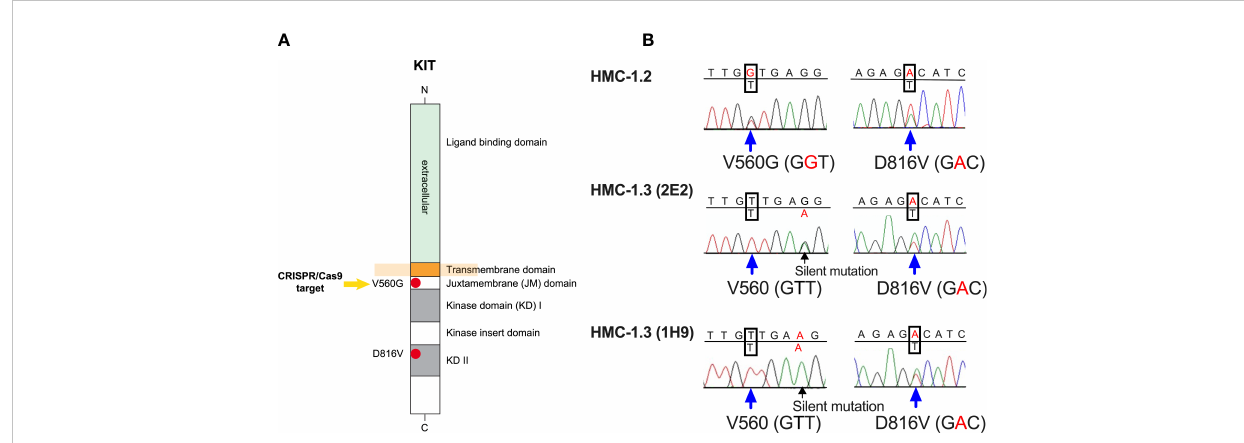
FIGURE 1 The huMC line HMC-1.3 generated by CRISPR/Cas9-mediated editing of HMC-1.2 cells has a single D816V-KIT mutation. (A) Schematic representation of the structure of KIT, highlighting the presence in HMC-1.2 cells of the oncogenic V560G variant in the juxtamembrane (JM) domain and of D816V-KIT in the kinase domain (KD). The arrow indicates the target mutation for CRISPR/Cas9 editing. (B) Representative Sanger sequencing chromatograms of KIT exons from HMC-1.2 or two separate clones (1H9 and 2E2) of HMC-1.3 cells, demonstrating heterozygous presence of D816V in both HMC-1.2 and in HMC-1.3, and a heterozygous V560G mutation in HMC-1.2 (GGT) that was reversed to the normal allele on this site (GTT) after the CRISPR/Cas9-mediated editing in